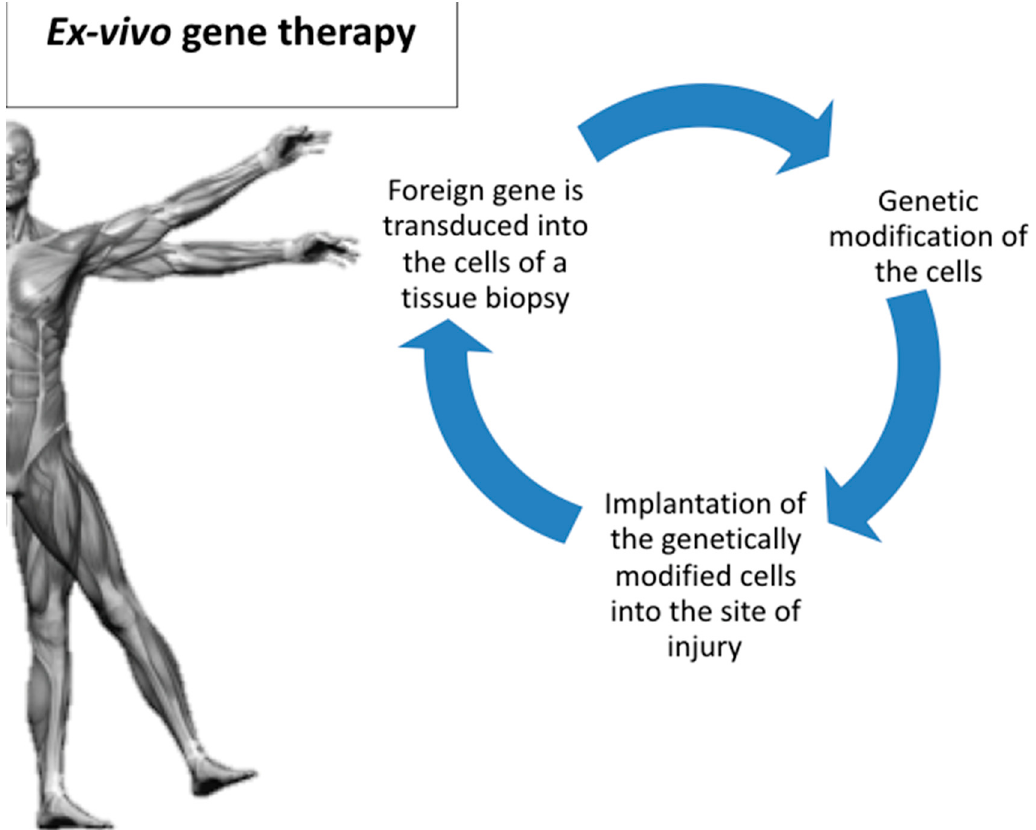
Figure 2. Ex vivo gene delivery.